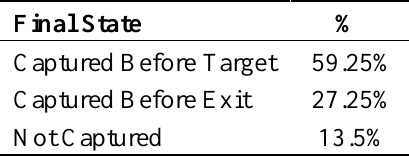
Table 3. Percentages of different states of the intruders after the testing